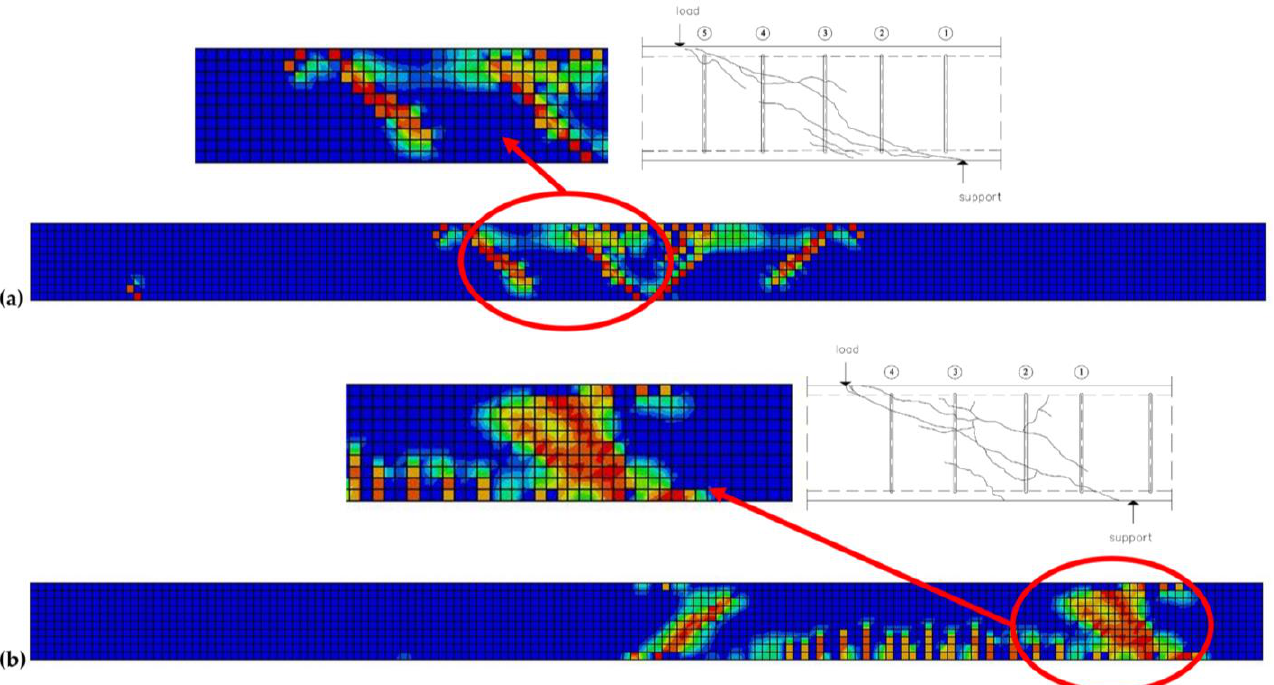
Figure 8. Concrete crack patterns of ( a ) A-C-17, and ( b ) A-S-17 beams.